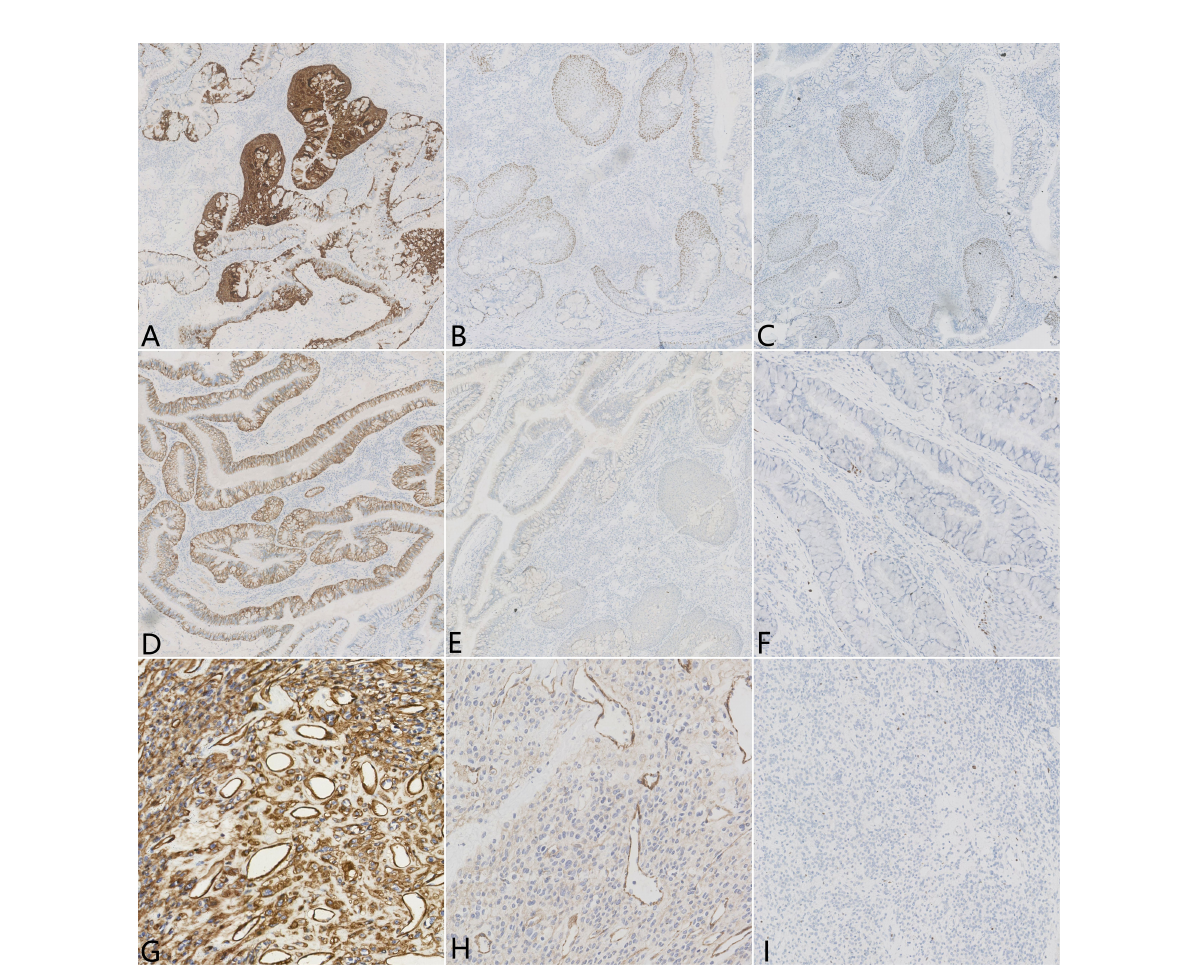
FIGURE 3 Immunohistochemical results of the pulmonary collision tumor. Epithelial element stains were positive for (A) CK5/6, (B) P63, (C) P40, and (D) CK7 but negative for (E) TTF-1. (F) Ki-67 was positive on the basal side of the areas of squamous epithelial, approximately 1% – 2%. Mesenchymal element stains were diffusely positive for (G) collagen IV and (H) MSA. (I) The percentage of Ki-67 expression in the area of glomus tumor cells was less than